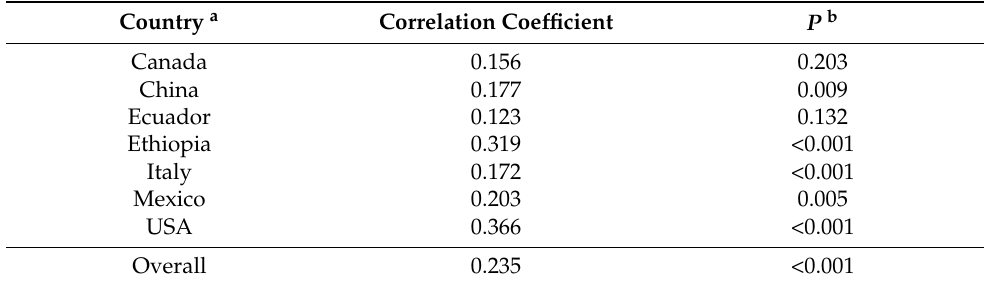
Table 7. Correlation coefficients between the molecular data (SSR) and virulence data of Puccinia striiformis f. sp. tritici collections from different